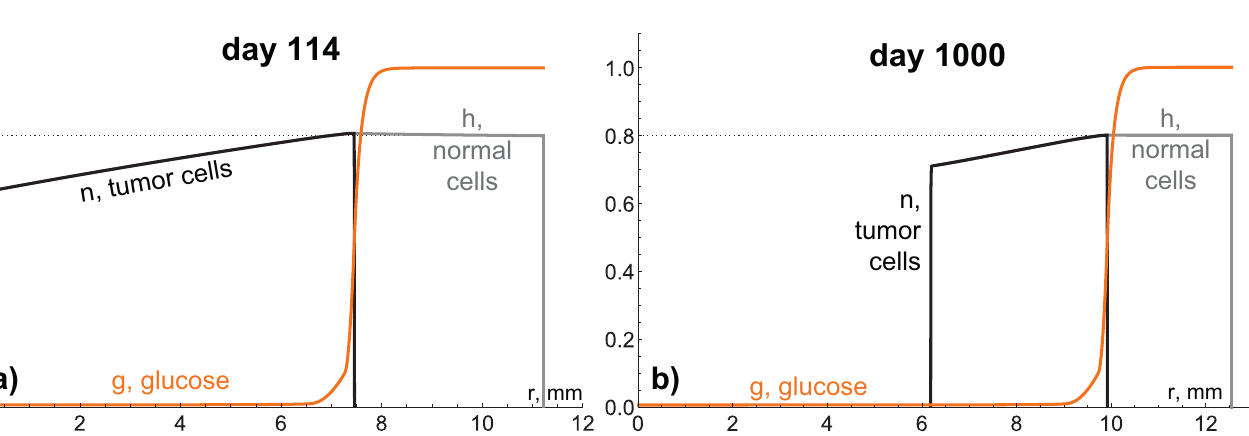
Figure 8. Distributions of the variables of the tumor growth model, governed by the system of Equation (6), produced by numerical simulations under tissue hydraulic conductivity K / µ = 0.3 and nutrient supply level P = 64 on the ( a ) 114th day of tumor growth and ( b ) 1000th day of tumor growth, at which the tumor core is filled with fluid. Dotted lines denote the value of initial fraction of cells c 0